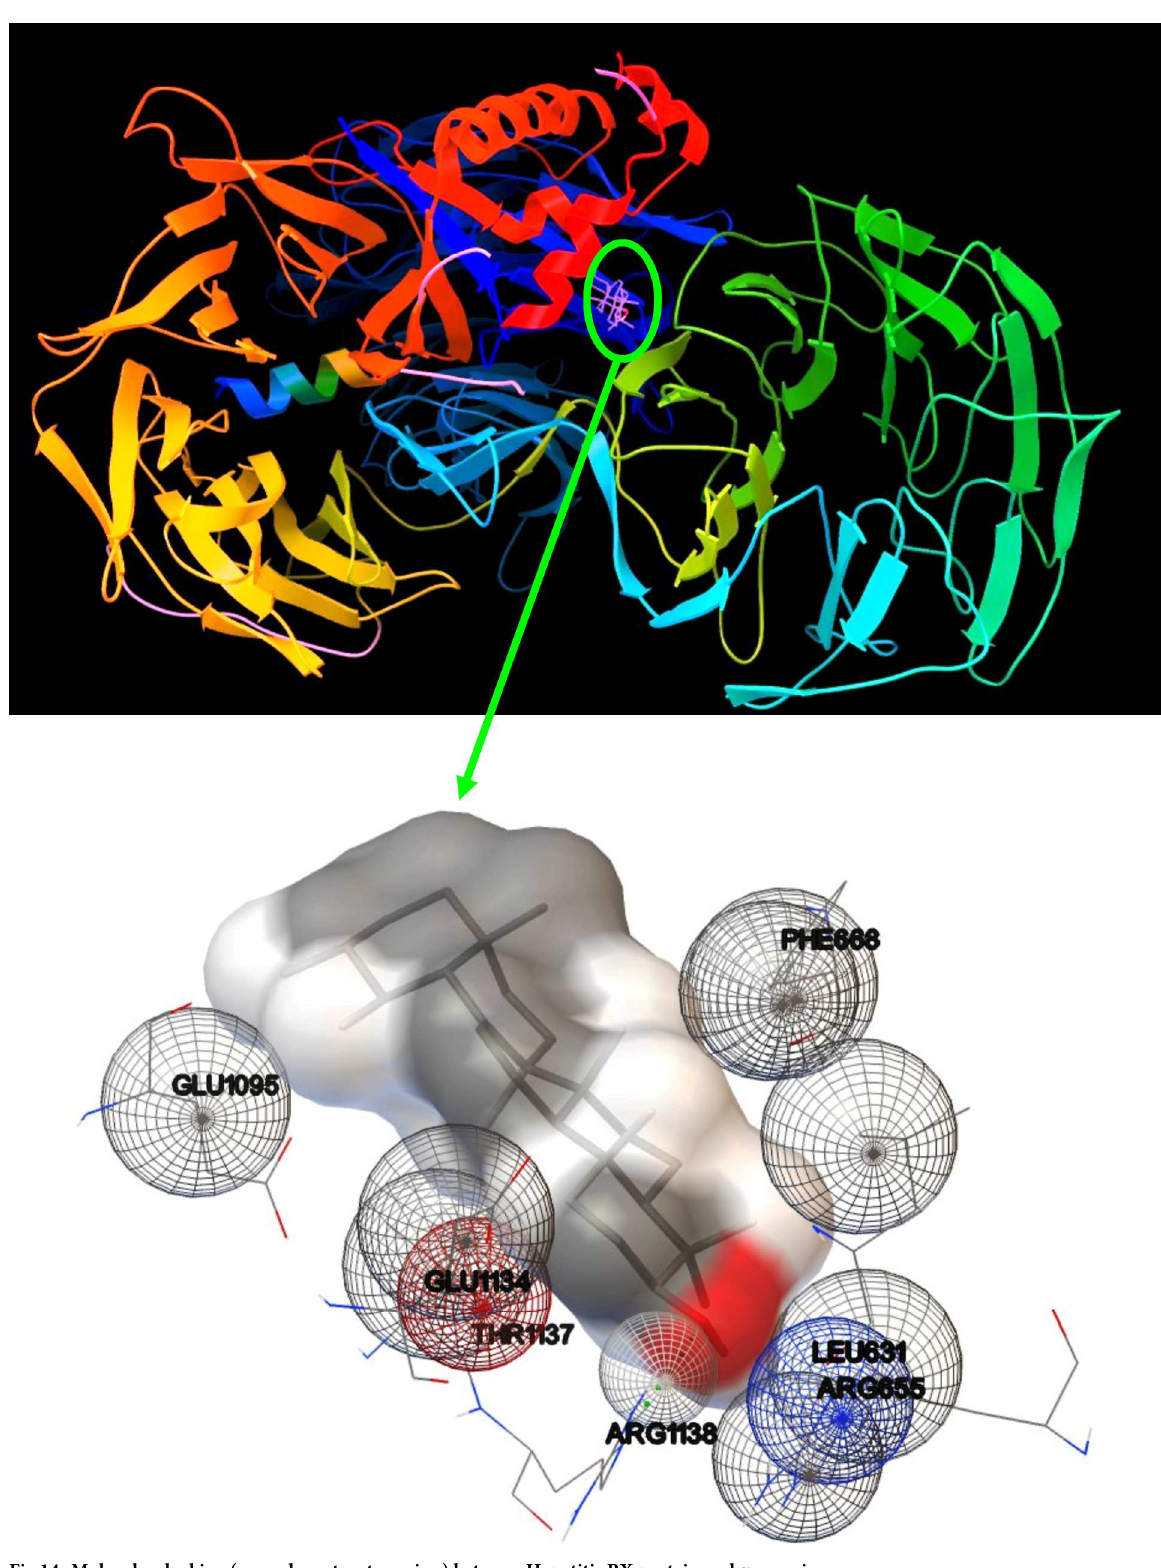
Fig 14. Molecular docking (secondary structure view) between Hepatitis BX protein and α -amyrin.